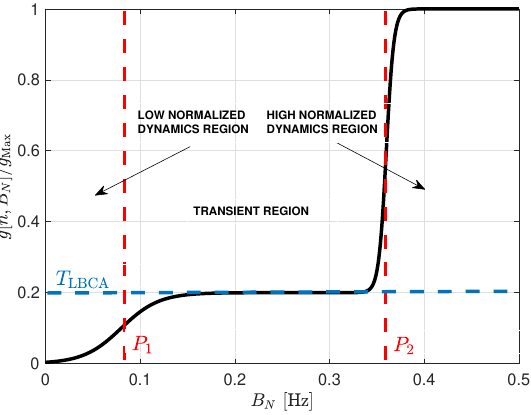
Figure 10. Weighting function of